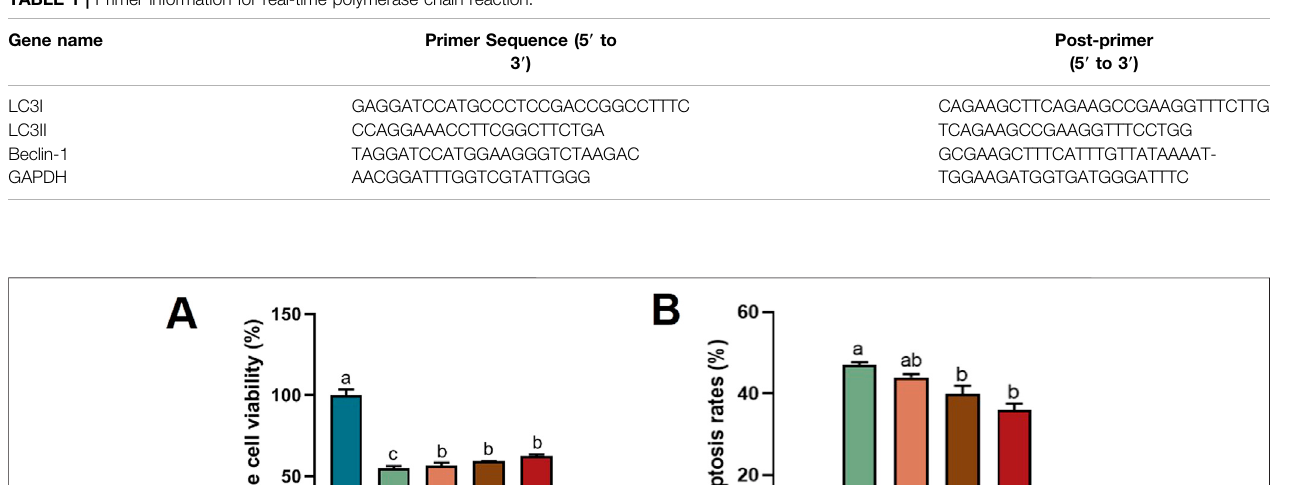
TABLE 1 | Primer information for real-time polymerase chain reaction.